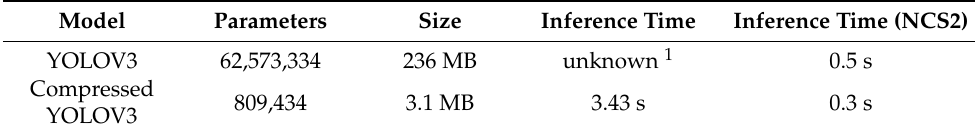
Table 3. Performance of YOLOV3 model and pruned-YOLOV3